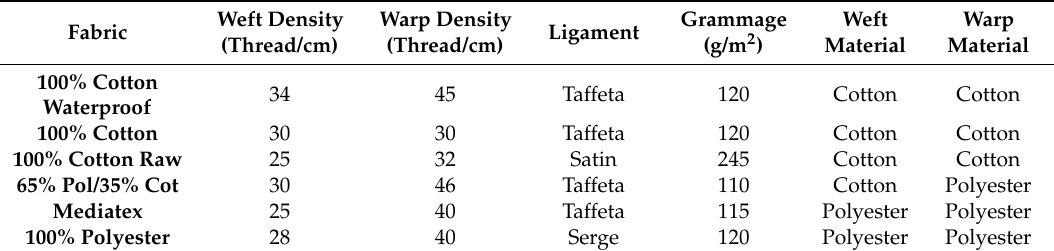
Figure A7. ( a ) Correct alignment; and ( b ) incorrect alignment. Table A1. Characteristics of the different fabrics used.